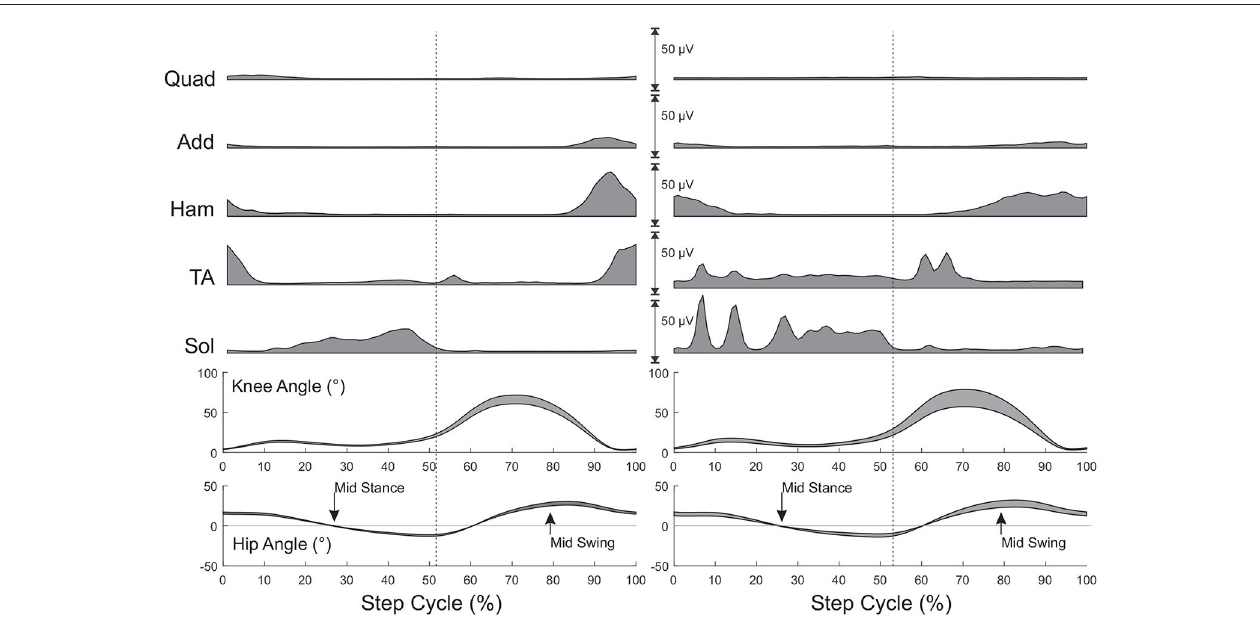
FIGURE 2 | Muscle activity and joint angles during stepping for a subject without injury (Left) and a subject with SCI (Right) . All values are time normalized to 100% of the step cycle. Muscle activity is the mean activity at each 1% of the step cycle over 25 steps prior to eliciting reflexes. Joint angles represent mean ( + SD) during the same steps. Arrows indicate mid stance and mid swing phase of stepping when reflexes would be triggered. Mid stance and mid swing hip joint angles were established during this initial stepping period. Vertical dashed lines represent the transition from stance to swing.